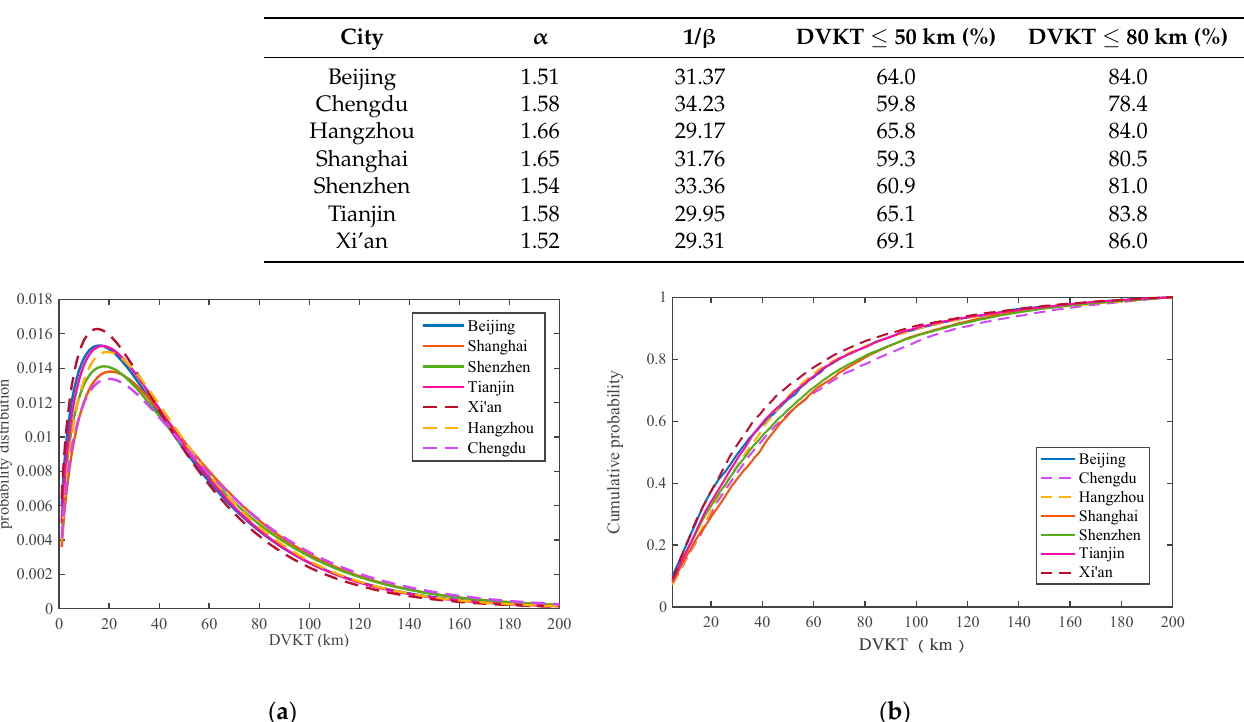
Table 3. DVKT fitted gamma distribution.